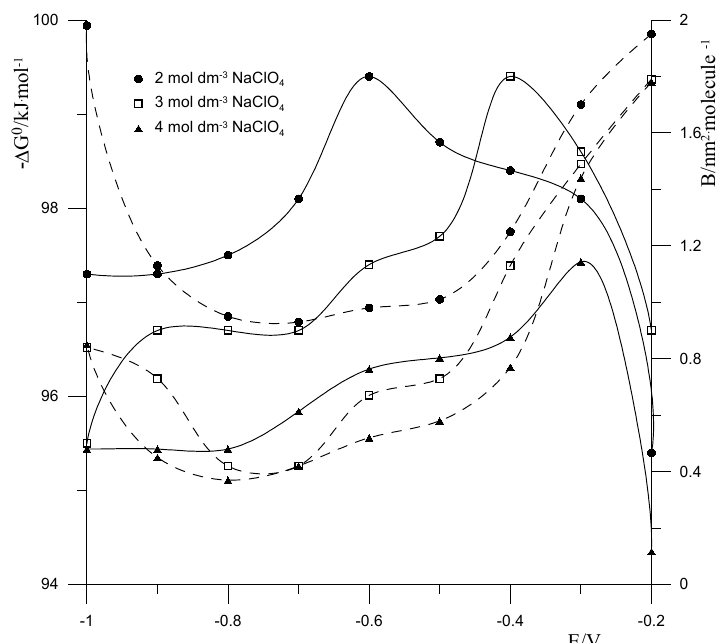
Figure 7. Variation of the Gibbs energy of adsorption D G 0 (solid lines) and of the 2D second virial coefficient B (dashed lines) due to electrode potential and NaClO concentration for tert -butanol, derived from the virial 4